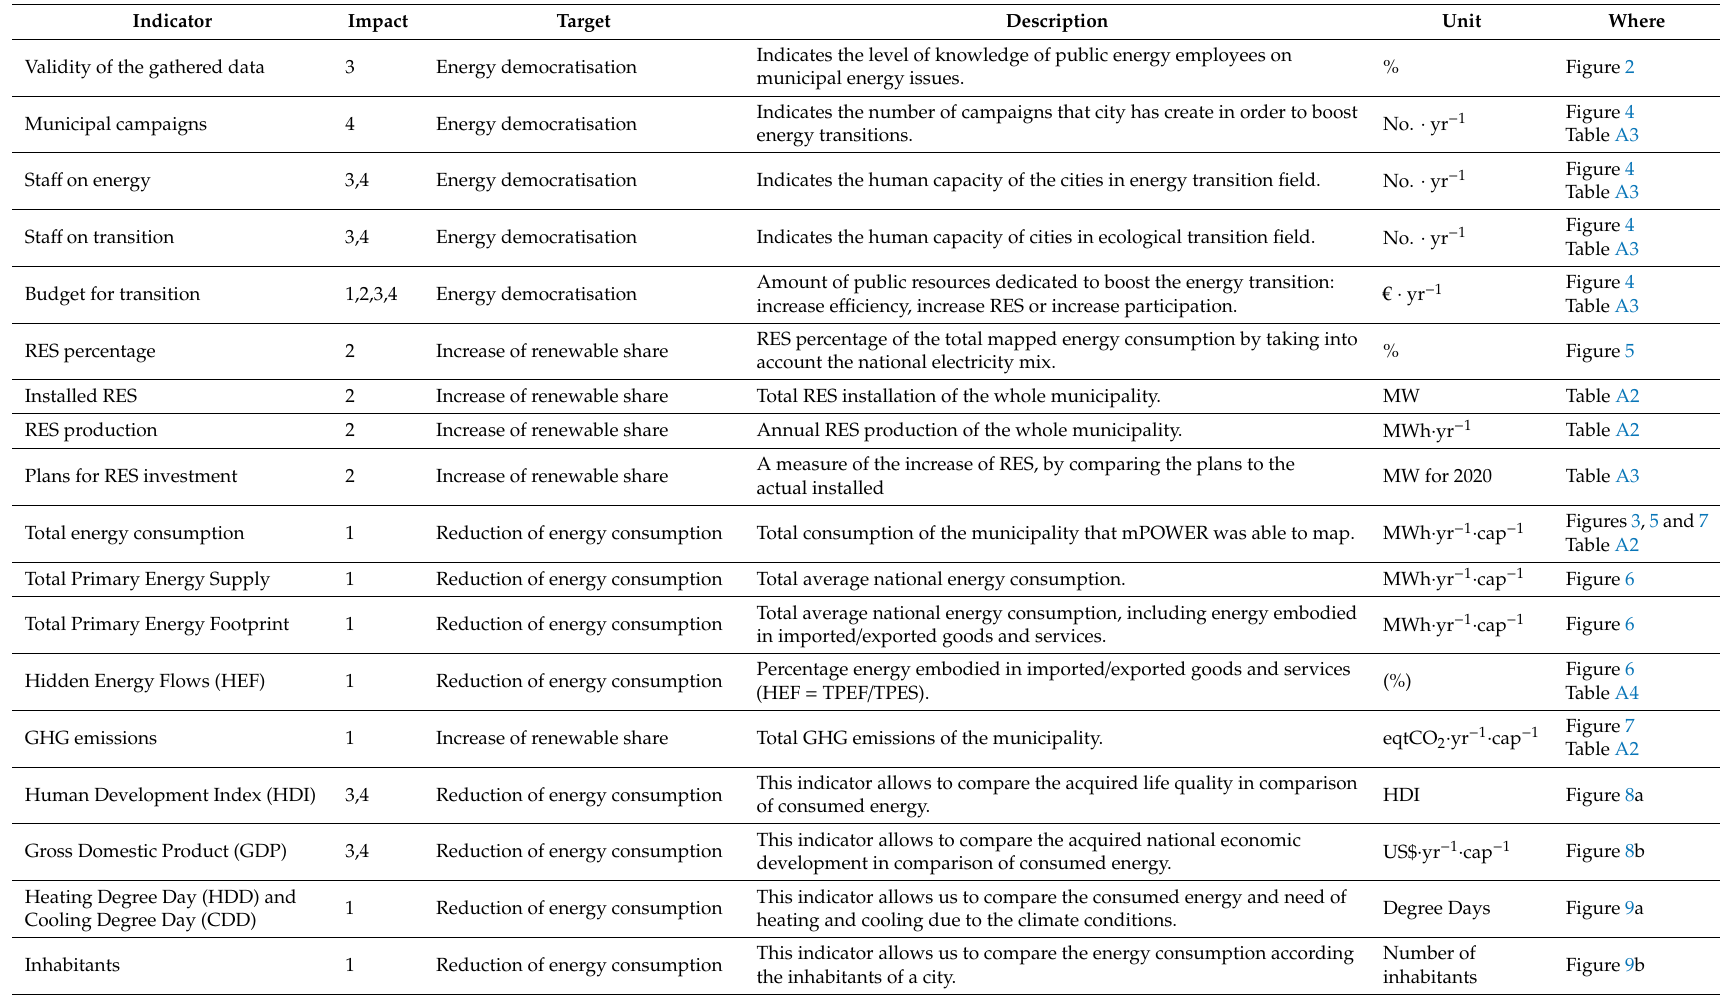
Table 1. Indicators used in the paper in order to analyse and compare the 27